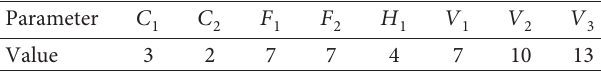
) on each player. (a) Effect of ecological com- 1 Table 9: The values of parameters in the simulation of the eco- logical compensation paid by the central government ( H 2